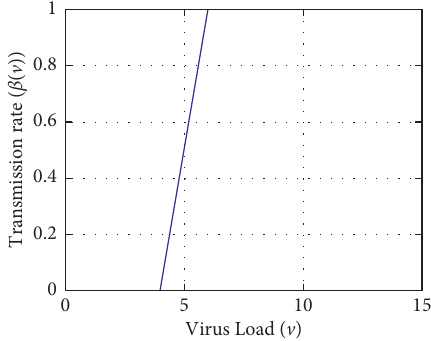
Figure 2: Membership function β